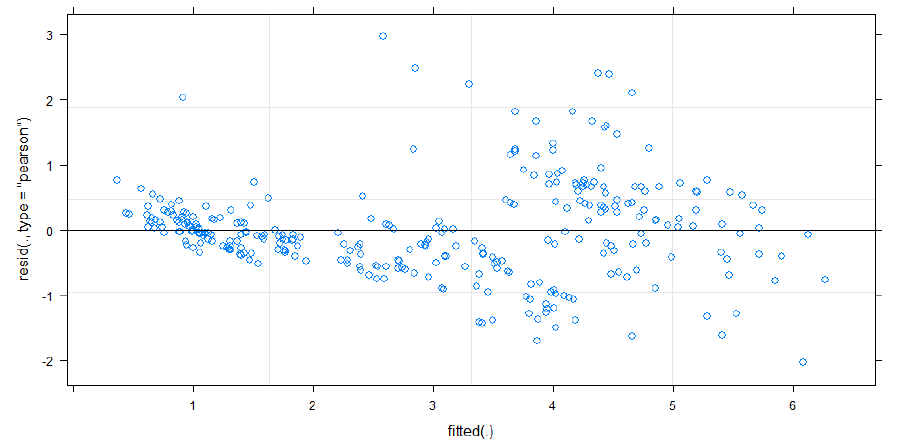
Table 2. Results from a mixed-effects linear regression model predicting speed with repeat meas- urements in individual dog accounted for with an intercept-only random effect.